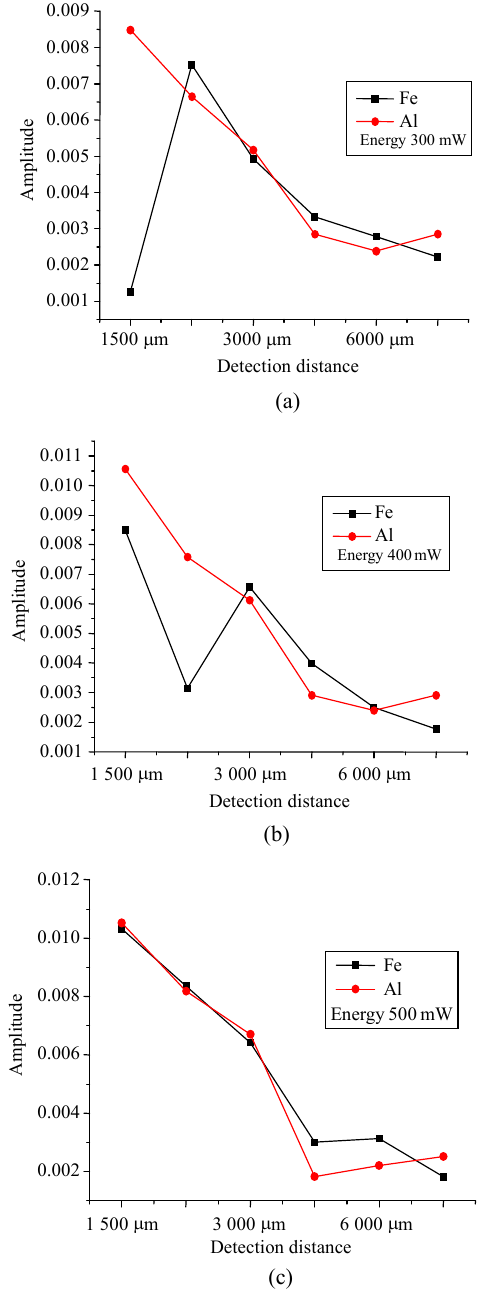
Fig. 5 Spectrum amplitude of the acoustic emission signal for Fe and Al at different energies: (a) energy 300 mW, (b) energy 400 mW, and (c) energy 500